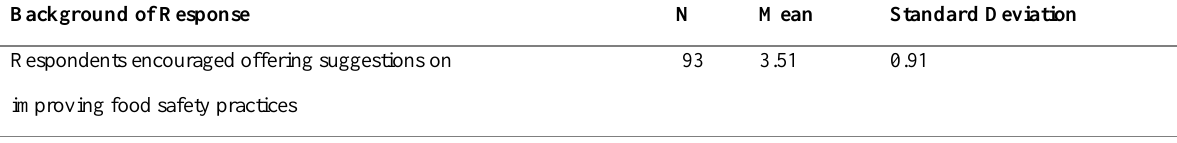
Table 2 : Respondents Encouraged Offering Suggestions on Improving Food Safety Practices